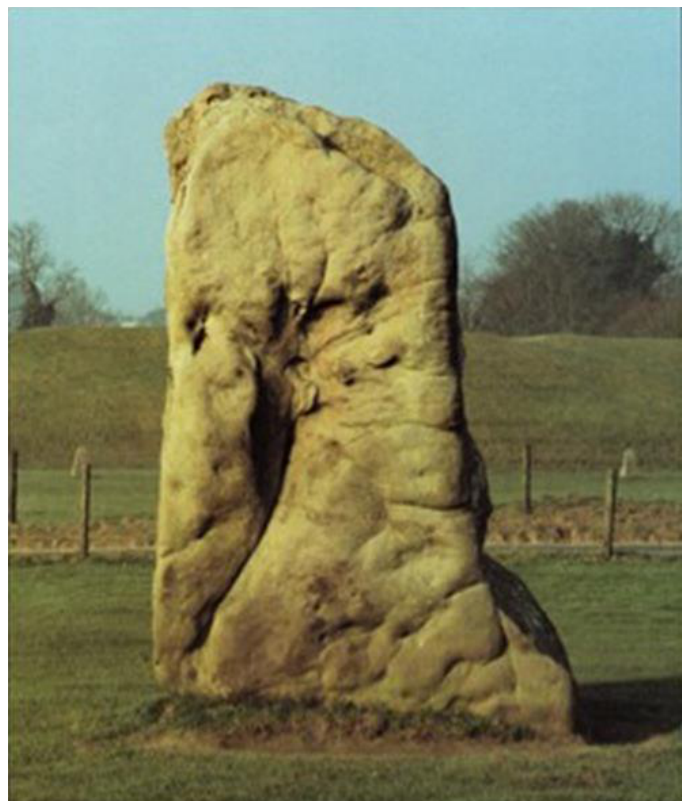
Figure 21. Stone 106 of the South Circle at Avebury was set to align with the Obelisk such that at Beltane sunrise the shadow of the Obelisk would fall upon it (compare with the plan in Figure 20). (Author’s photograph)